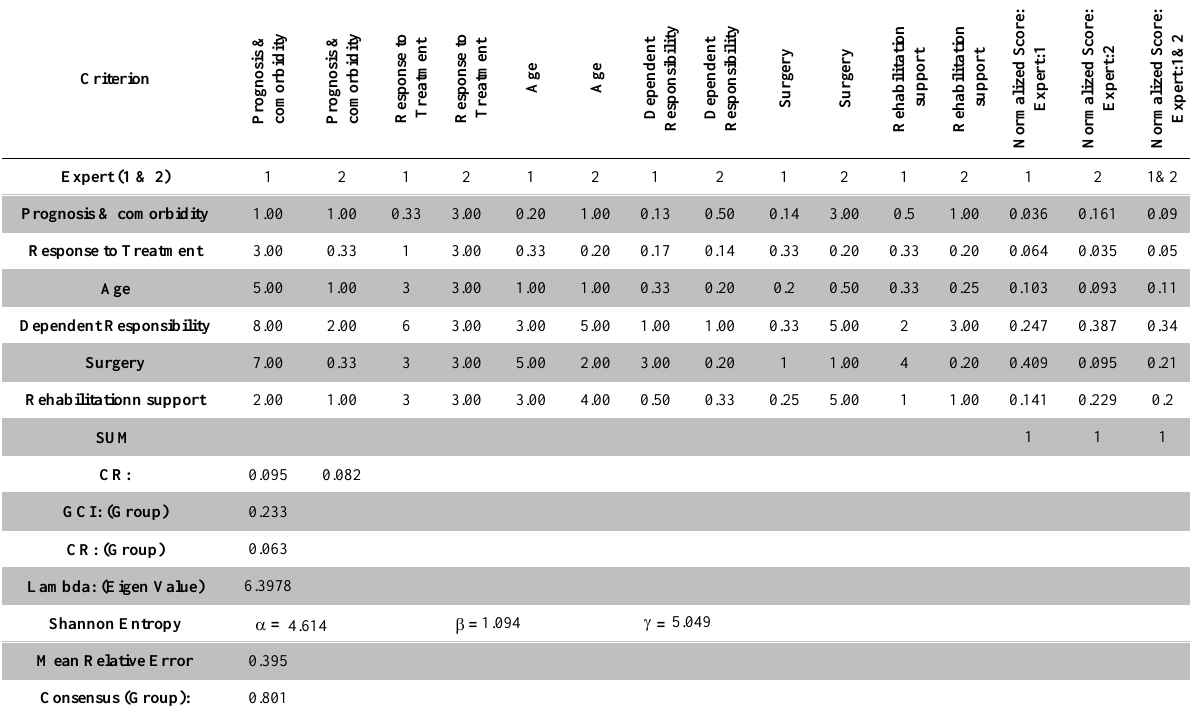
Table 10. Decision Matrix A: About Patient Case 1 (Expert 1 and 2)